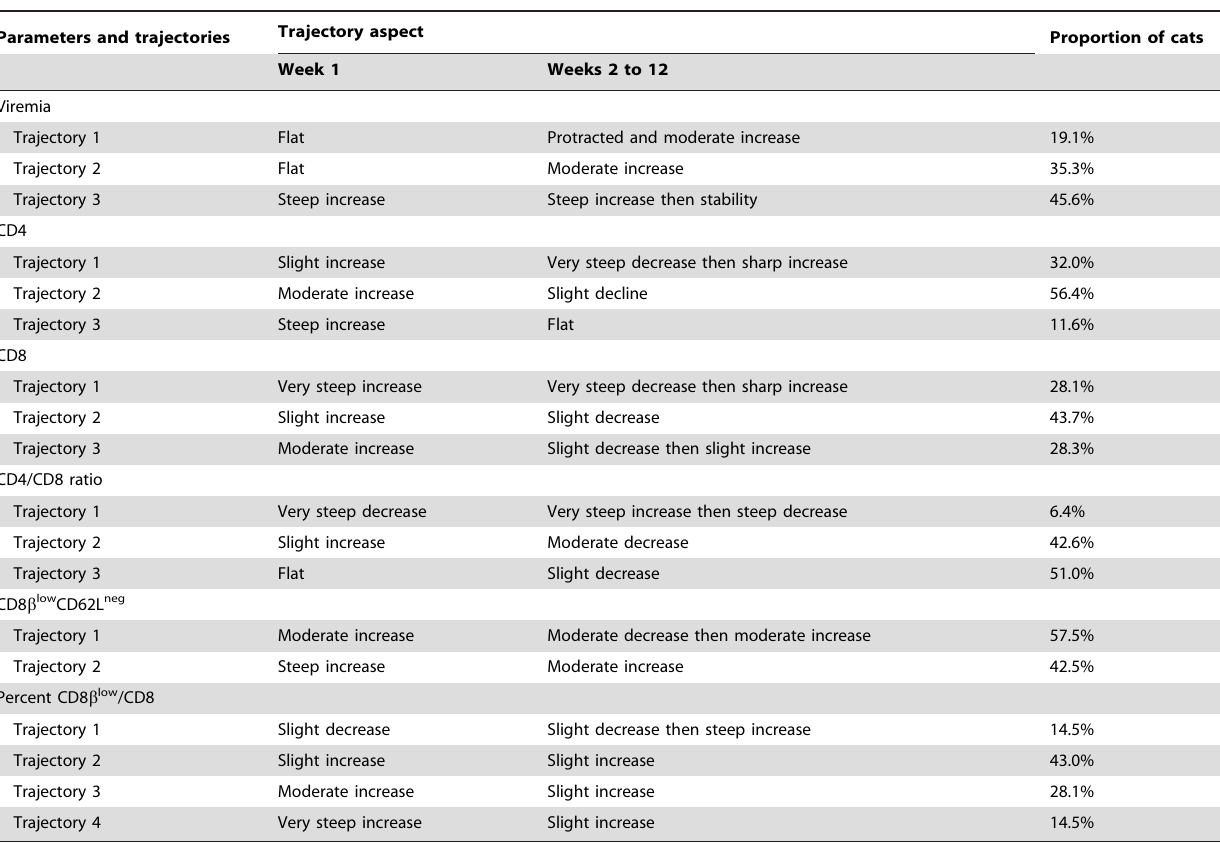
Table 3. Aspect of the trajectories of viremia and changes in T-cell markers.